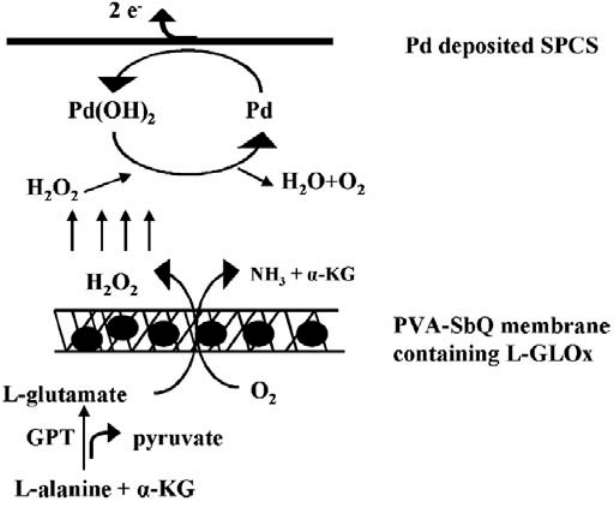
Figure 9. Schematic diagram displaying the enzyme and electrode reactions involved in the GPT activity determination at an SPCS/ Pd/PVA-SbQ/ L -GlOx electrode [40]. Also, some works focused on not only electrode modification but also analysis system